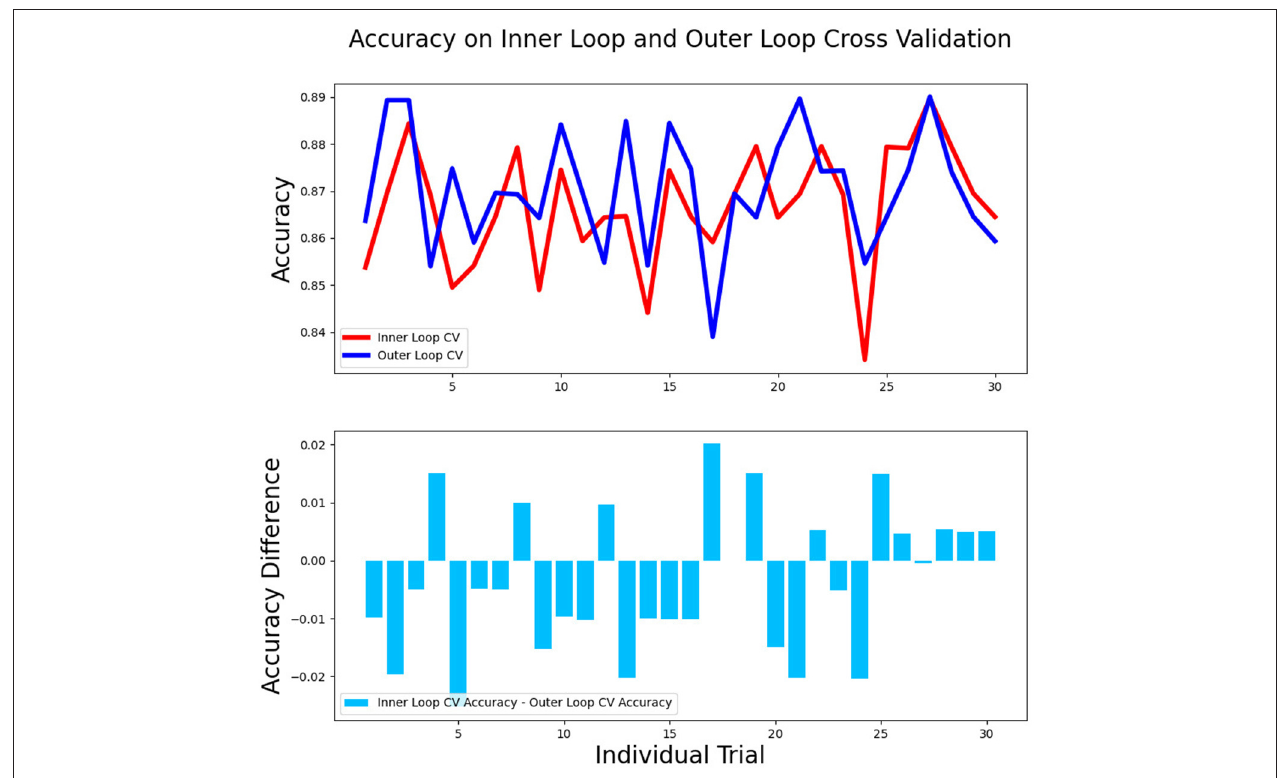
FIGURE 7 | The accuracy between the validation dataset in the inner loop and testing dataset in the outer loop for 30-round